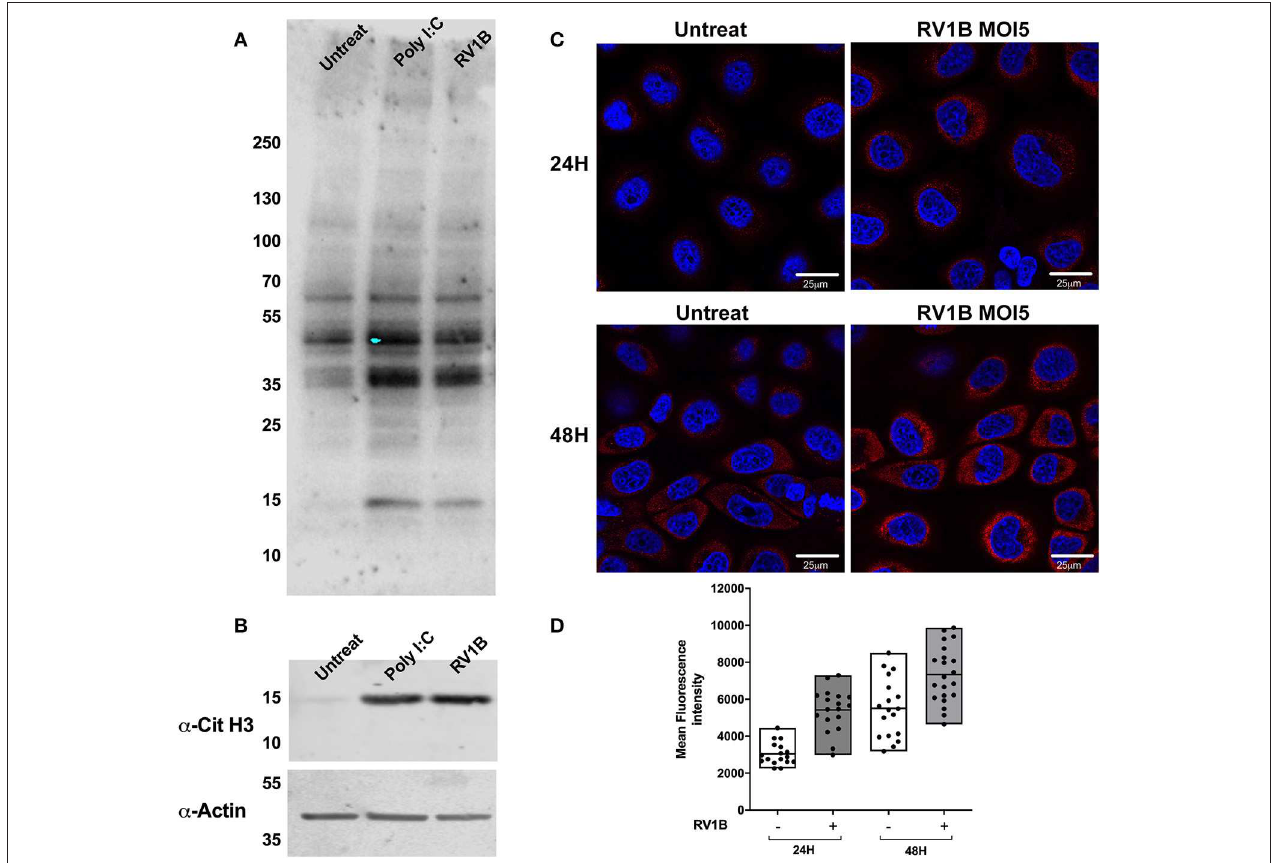
FIGURE 5 | Human rhinovirus and Poly I:C stimulation increase protein citrullination in 16HBE14 ◦ − cells. Human bronchial epithelial (16HBE14 ◦ − ) cells were infected with HRV1B MOI = 5 or treated with Poly IC and total citrullination was measured with a monoclonal antibody against peptidyl citrulline (F95). (A) After 24h, lysates were obtained and blotted with F95 antibody, α -citrullinated histone H3, and actin, which was used as loading control. (B) Confocal microscopy images were also taken at 24 or 48h after infection, showing F95 staining (RED) and DAPI as nuclear counterstaining (BLUE). (C) Quantification of at least four different fields of view from (C) is shown in (D) , with each dot representing a different cell and boxes displaying min to max and mean values of F95 staining